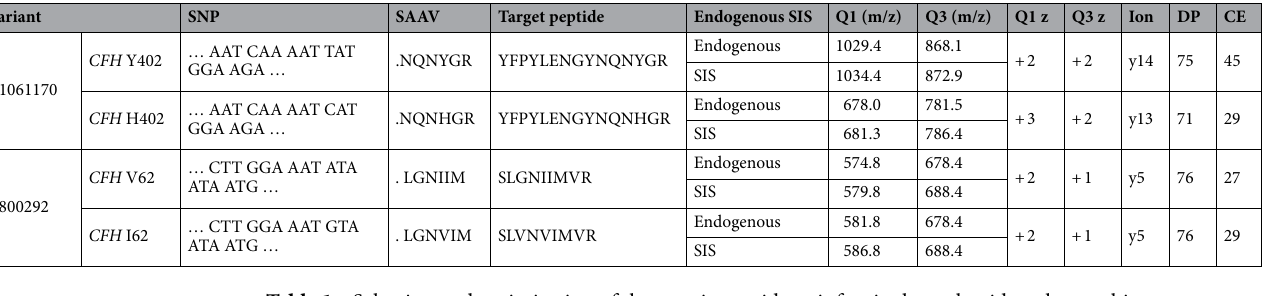
Table 1. Selection and optimization of the tryptic peptide to infer single nucleotide polymorphism genotype in multiple reaction monitoring assays. SNP, single nucleotide polymorphism; SAAV, single amino acid variant; SIS, stable isotope-labeled; m/z, mass to charge; DP, declustering potential; CE, collision energy; CFH, complement factor H; T, thymine; C, cytosine; A, adenine; G, guanine; Y, tyrosine; H, histidine; I, isoleucine; V,